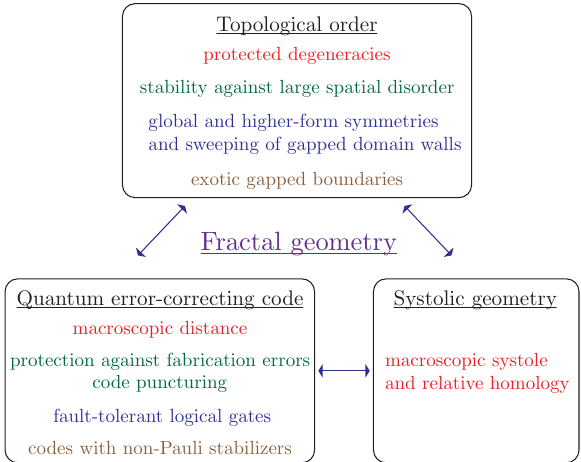
FIG. 1. A summary of the motivation and scope of this paper and the correspondence among the three fields at the inter- face of fractal geometry. Items with the same color indicate the equivalence of concepts in different